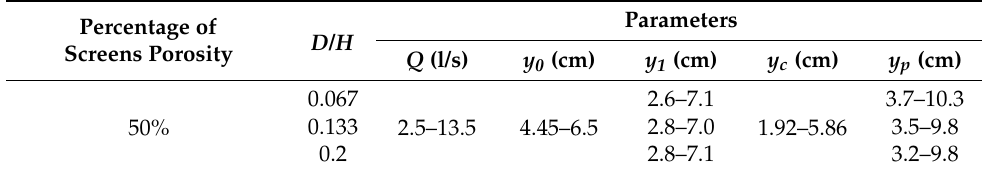
Table 1. Variation range of parameters in the present